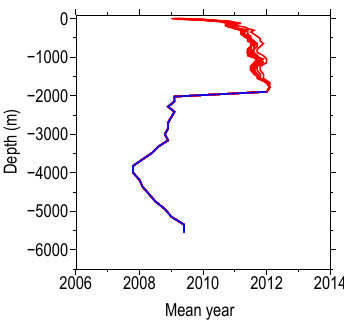
Figure 6. Area-mean climatological year vs. depth. Monthly values above 1900m are shown in red.